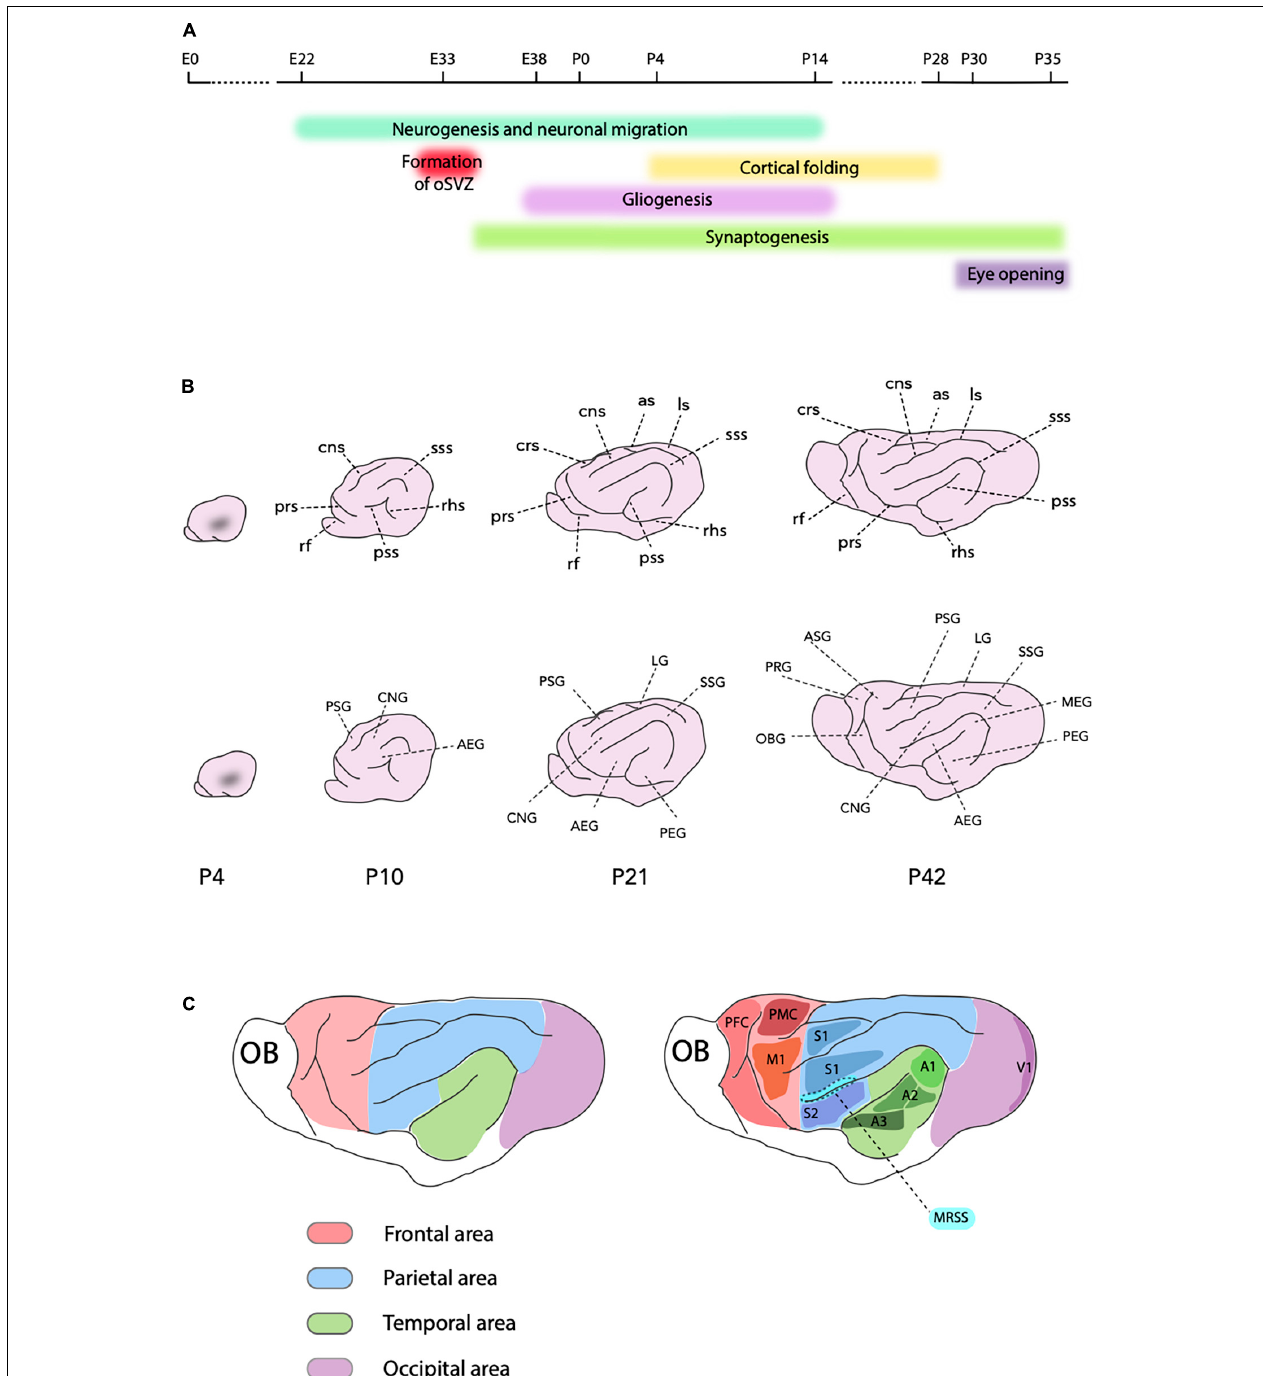
FIGURE 2 | Ferret neocortex development. (A) Schematic timeline showing key processes in the ferret neocortex development and the timing of the eye opening. (B) Scheme of development of the ferret cortical folding from P4, when the first indentation is visible, until P42, the fully mature stage (on all schemes, rostral is left and dorsal is up). Intermediate P10 and P21 stages are also shown. Upper part shows main sulci (in the clockwise order, P42): as, ansinate sulcus; ls, lateral sulcus; sss, suprasylvian sulcus; pss, pseudosylvian sulcus; rhs, rhinal sulcus; prs, presylvian sulcus; rf, rhinal fissure; crs, cruciate sulcus; cns, coronal sulcus. Lower part shows main gyri (in the clockwise order, P42): PSG, posterior sigmoid gyrus; LG, lateral gyrus; SSG, suprasylvian gyrus; MEG, medial ectosylvian gyrus; PEG, posterior ectosylvian gyrus; AEG, anterior ectosylvian gyrus; CNG, coronal gyrus; OBG, orbital gyrus; PRG, proreal gyrus; ASG, anterior sigmoid gyrus. (C) Principal cortical areas in the ferret. Red, frontal area (PFC, prefrontal cortex; PMC, premotor cortex; M1, primary motor cortex); Green, temporal area (A1, primary auditory cortex; A2, secondary auditory cortex; A3, tertiary auditory cortex); Blue, parietal area (S1, primary somatosensory cortex; S2, secondary somatosensory cortex; MRSS, medial rostral suprasylvian area); Violet, occipital area (V1, primary visual cortex or area 17); OB, olfactory bulb.